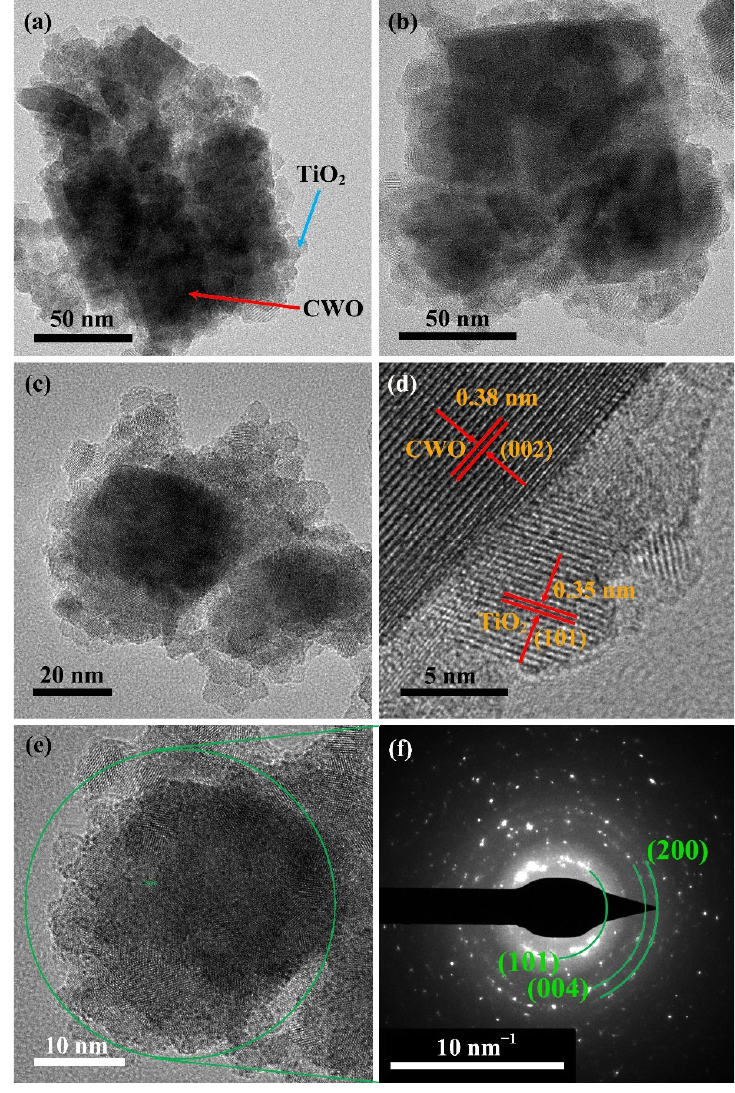
Figure 4. TEM images of the ( a ) CWO@0.2TiO 2 , ( b ) CWO@0.4TiO 2 , ( c ) CWO@0.6TiO 2 ; HRTEM image of the ( d ) CWO@0.2TiO 2 ; SAED of the CWO@0.2TiO 2 (e) selected area, (f) diffraction rings. The chemical states of the coated samples was carefully determined by XPS. The full range XPS spectra and W 4f core-level spectra of CWO@0.2TiO 2 are given in Figure 5. Except the existence of Cs, W, O, and Ti elements, no other impurity elements were found in the full range XPS spectra, which is consistent with the element spectrum results in Figure 3e. The W 4f core-level XPS spectra of CWO@0.2TiO 2 can be fitted as two spin-orbit doublets. The peaks at 37.3 and 35.2 eV were attributed to W 6+ , and the peaks at 36.1 and 33.8 eV were attributed to W 5+ , respectively. The NIR shielding properties of CWO are determined by the plasmon resonance of free electrons. The addition of Cs element into WO 3 structure can reduce part of W 6+ to W 5+ , so as to enhance the carrier concentration and small polaron mechanism [22], which is the reason why CWO material has high NIR shielding